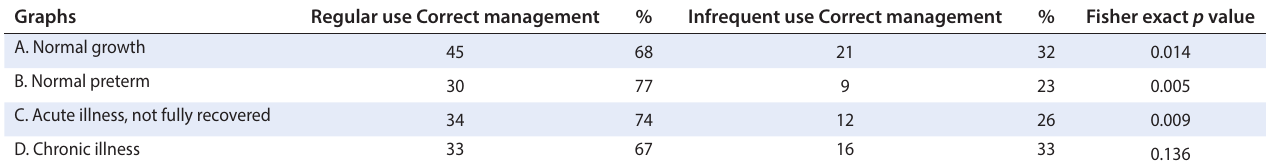
Table 3: Accuracy of management by reported growth chart usage levels